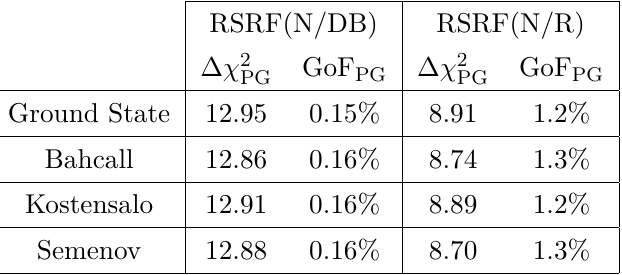
Table 3. χ 2 difference ∆ χ 2 of the parameter goodness of fit test [36] applied to the comparison PG of the neutrino oscillation fits of the reactor spectral ratio data and the Gallium data with the four Gallium detection cross sections in table 1. The values of the corresponding parameter goodness of fit GoF PG are calculated with two degrees of freedom corresponding to the two common oscillation parameters sin 2 2 ϑ ee and ∆ m 2 . The column titles RSRF(N/DB) and RSRF(N/R) indicate, respec- 41 tively, the combined fits of NEOS/Daya Bay and NEOS/RENO data with those of the other reactor spectral ratio experiments discussed in the text (DANSS, PROSPECT, STEREO, and